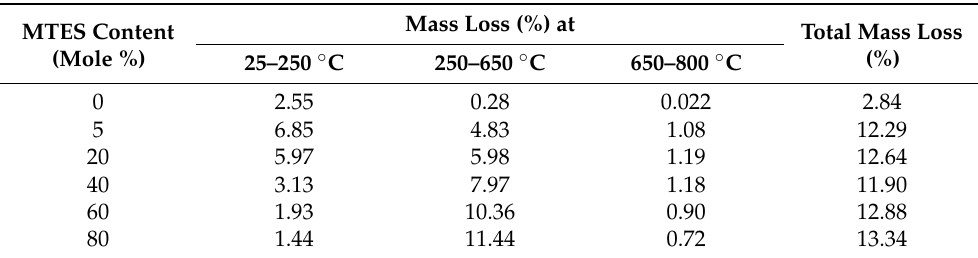
Table 2. Thermal behavior of series B silica xerogels synthesized with different MTES content (series B represents the pH =